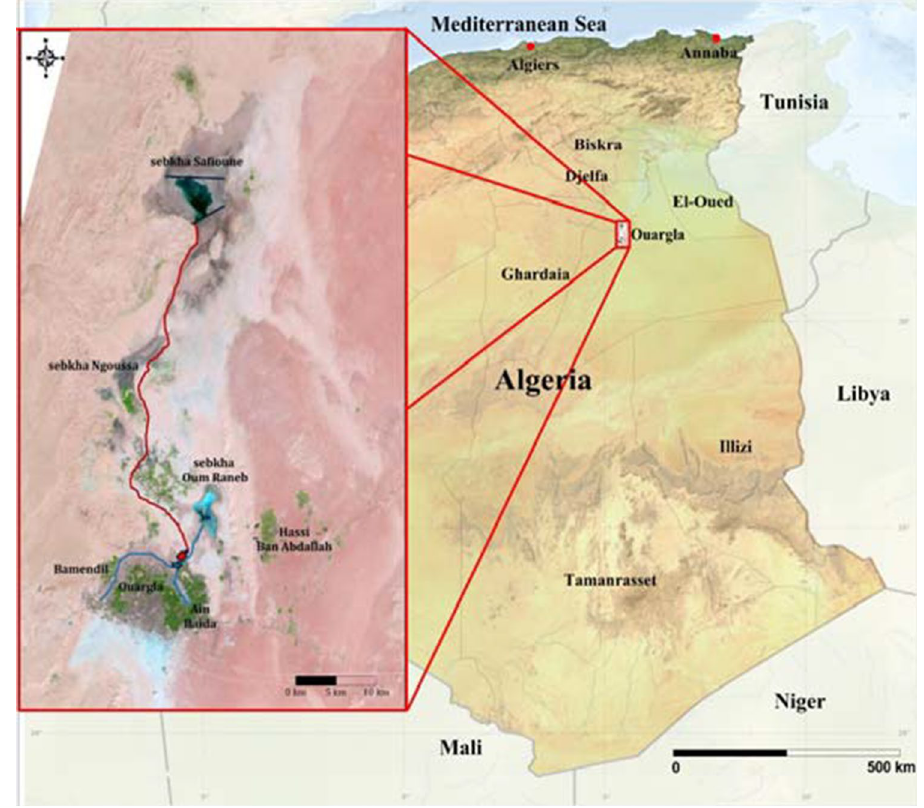
Fig. 1 Location map of the study